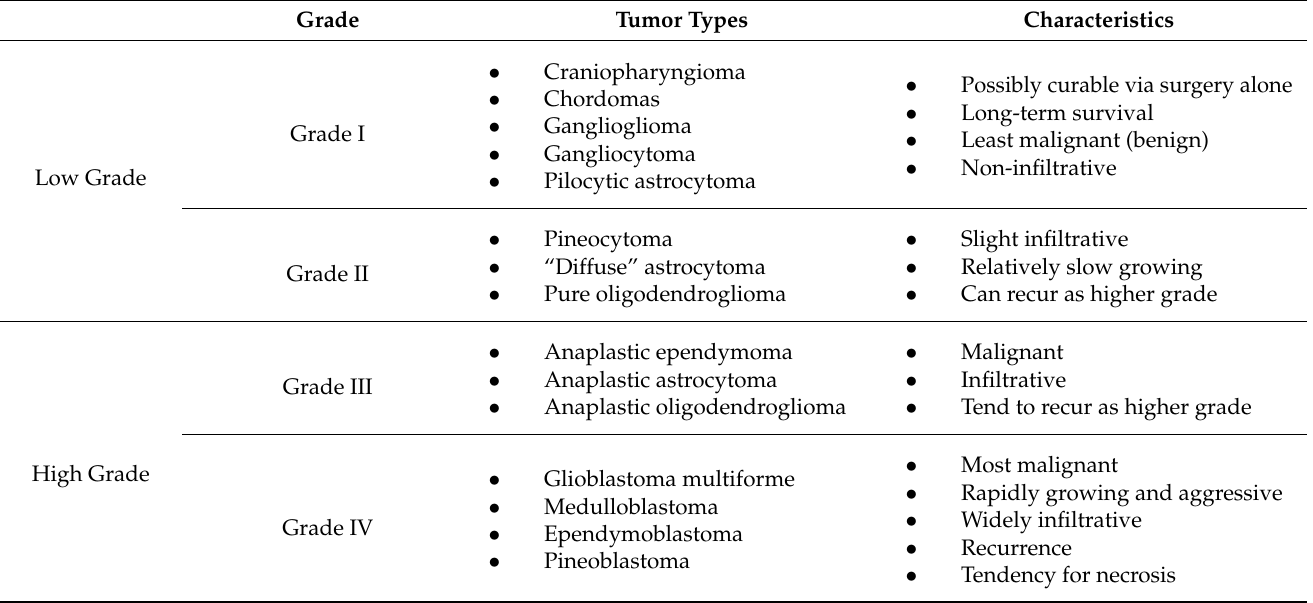
Table 1. WHO classification of brain tumor